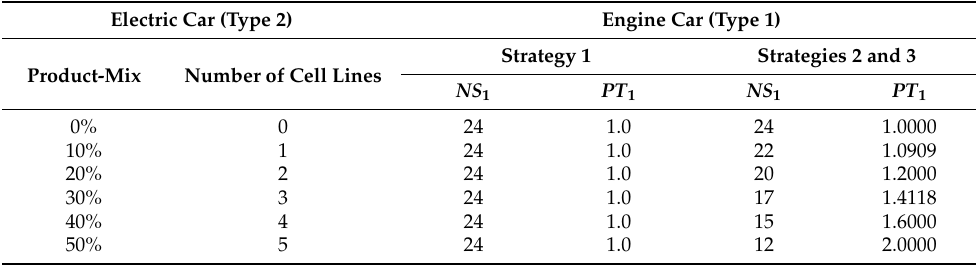
Table 3. Data for strategies 1, 2 and 3.